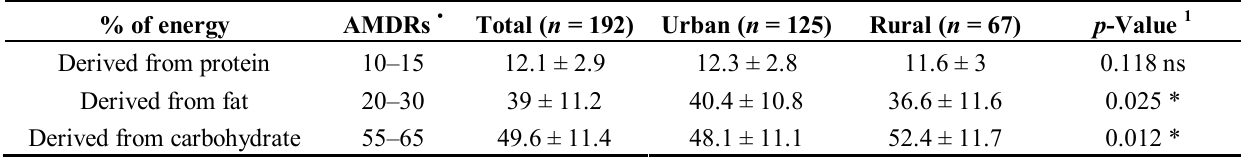
Table 2. Energy derived from protein, fat and carbohydrates expressed as the percentage of the total energy intake (kcal) of pregnant women living in urban and rural